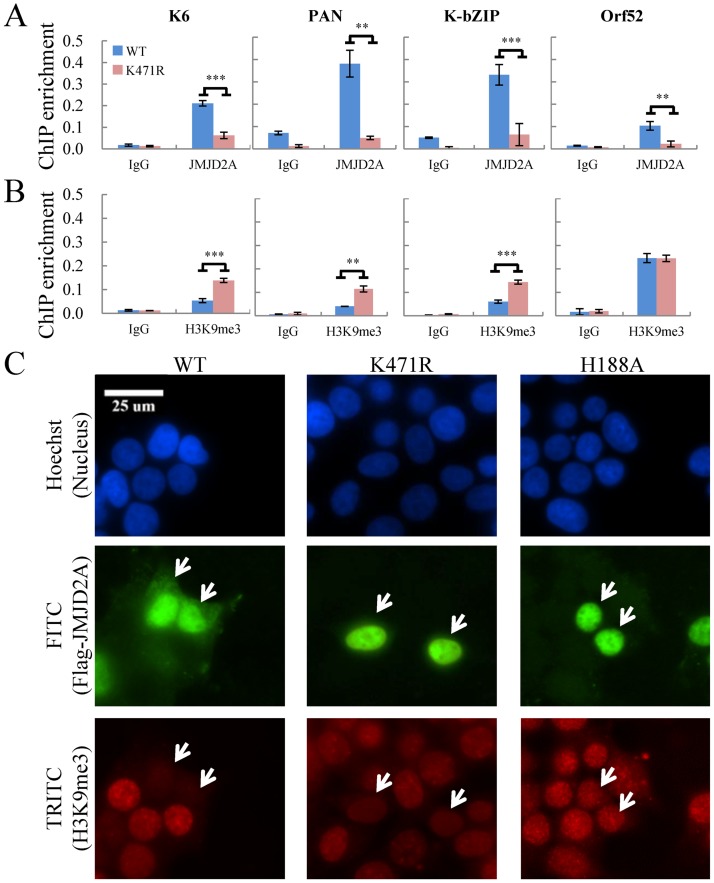
SUMOylation modulates the occupancy and demethylase activity of JMJD2A at target genes.(A and B) ChIP was performed with chromatin prepared from TREx-MH-K-Rta-shJMJD2A-Flag-JMJD2A-WT and -K471R BCBL-1 cells using rabbit IgG, anti-JMJD2A (A) and anti-H3K9me3 (B) antibodies. ChIP DNA was quantified as described in Fig 1C. (C) Histone demethylase activity of Flag-tagged JMJD2A-WT, -K471R or -H188A protein in 293T cells was assessed by immunofluorescence staining (IF) using deconvolution fluorescence microscopy. Cells were fixed, stained with antibody specific for Flag (FITC) and H3K9me3 (TRITC), and mounted in Slow Fade Gold with DAPI. White arrows indicate cells transfected with Flag-JMJD2A-WT or its mutant.